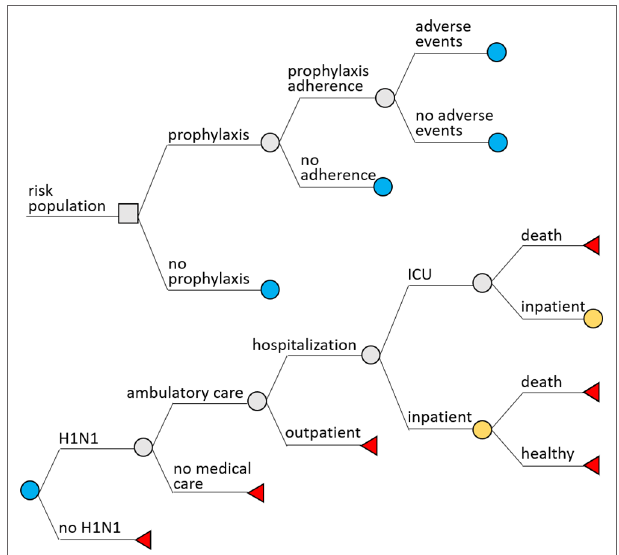
FIGURE 1 | Decision-tree model adopted in the